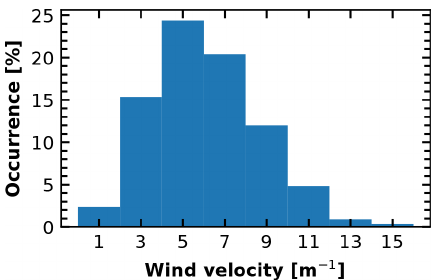
Figure 6. Histogram of the mean surface wind for any of the ana- lyzed 30min time